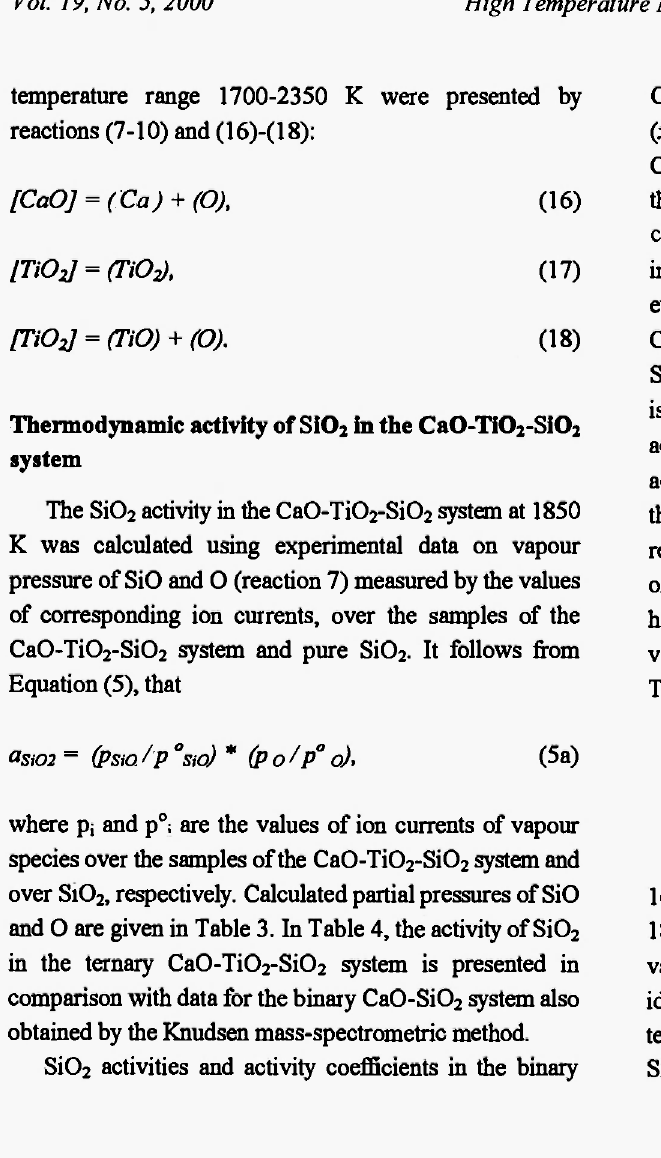
-Ti0 and binary Ca0-Si0 2 2